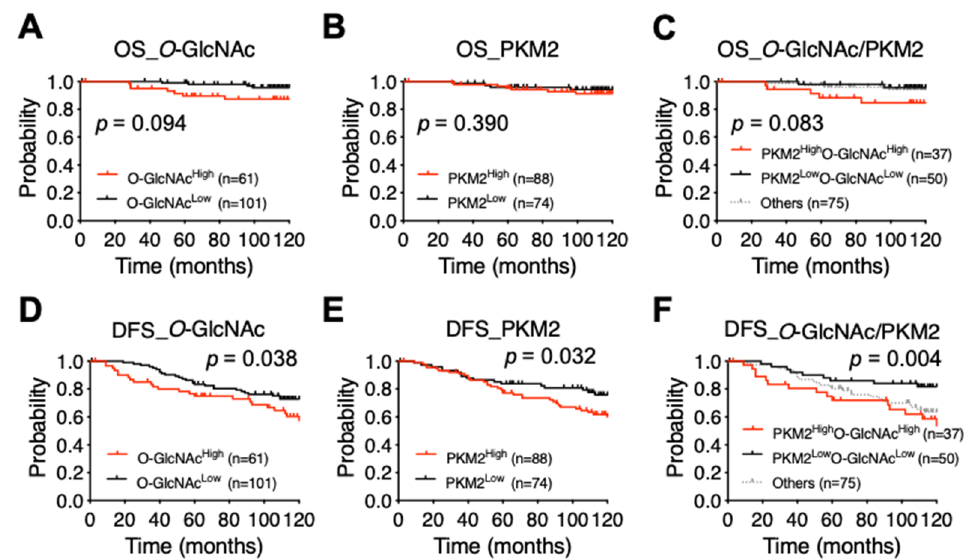
Figure 6. Survival of patients with ER + /HER2 − luminal BC according to the levels of O -GlcNAc and PKM2. ( A – C ) The Kaplan–Meier analysis of overall survival (OS) based on the expression level of O -GlcNAc ( A ) or PKM2 ( B ) alone or both ( C ). ( D – F ) Elevated expression of O -GlcNAc ( D ) or PKM2 ( E ) alone or both ( F ) is significantly correlated with 10-year DFS. For group comparisons, p -values for a single-marker (high vs. low) or double-marker ( O -GlcNAChighPKM2high vs. O - GlcNAClowPKM2low) statuses were determined by log-rank